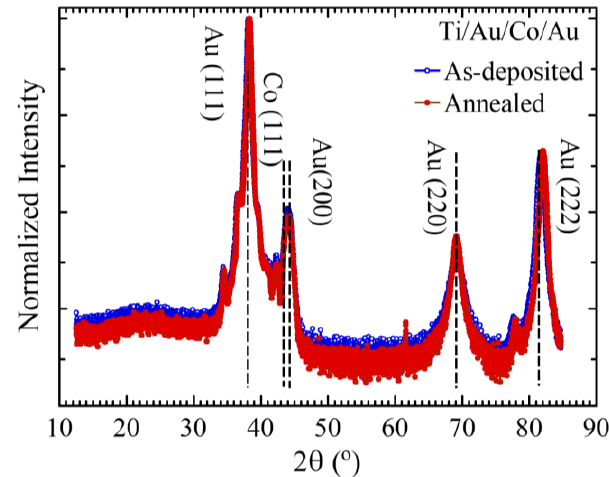
Figure 1. Comparison of high-angle X-ray diffractometer profiles for the as-deposited (denoted by blue) and annealed (denoted by red) Ti/Au/Co/Au multilayers.